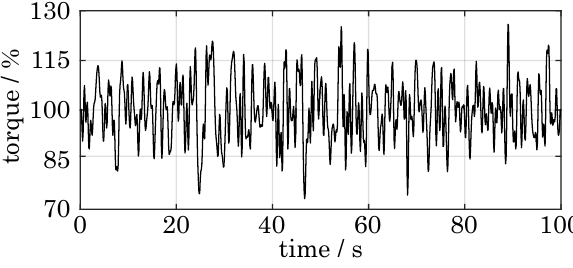
Figure 5: Torque-time history at gearbox output, Load: 150 t, Wind speed: Beaufort